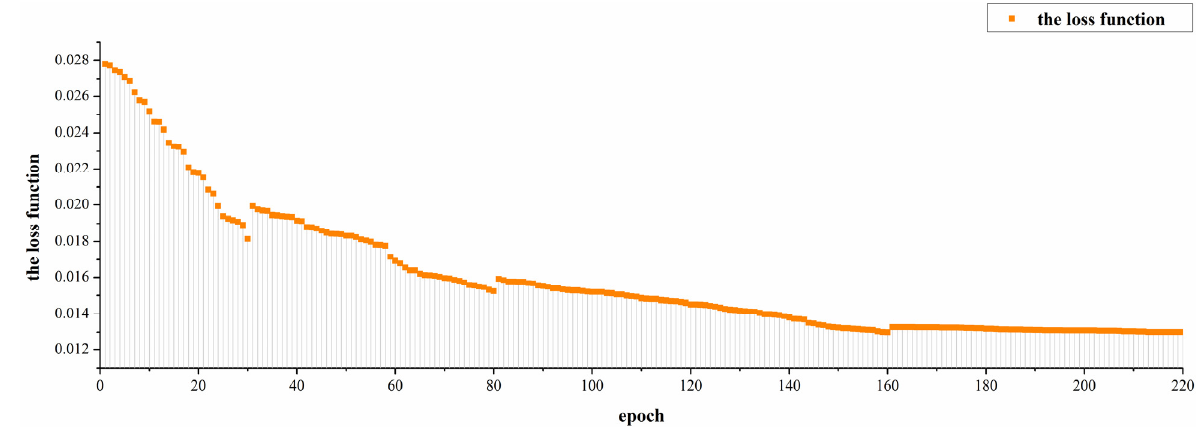
Figure 9. The variation curve of loss function value with the number of training rounds.